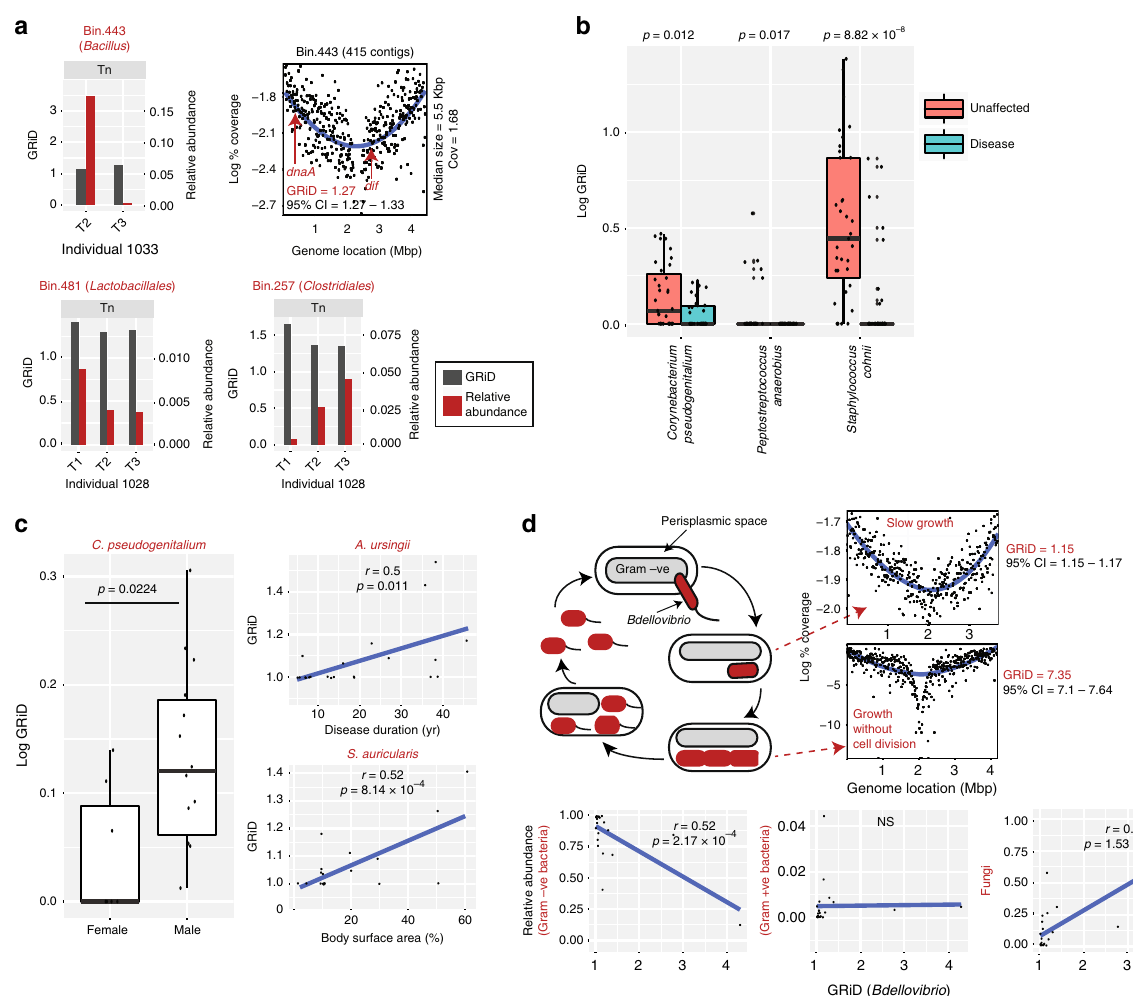
Fig. 2 GRiD uncovers new biology from human and environmental communities. a Growth rate of rare uncharacterized bacteria over time from a skin metagenomic dataset. Uncharacterized bacteria were identi fi ed using de novo assembly of reads and metagenomic binning, with each bin representing a genome. The sampling interval between timepoints T1 and T2 is 10 – 30 months while sampling intervals between T2 and T3 are 5 – 10 weeks. Tn = toenail. b Growth rate of bacteria that were signi fi cantly different ( p < 0.05, Wilcoxon rank-sum test) between unaffected and disease sites in a psoriasis skin metagenomic dataset. Center lines in boxplots represent the median and the edges represent the fi rst and third quartiles. c Inter-individual bacterial growth differences and association with patient characteristics. Each data point in the scatterplots represents the average GRiD score of each patient. Statistical differences between population groups were determined using the Wilcoxon rank-sum test while Spearman correlation was utilized for correlation coef fi cient analyses. d Growth dynamics of Bdellovibrio species. Flagellated Bdellovibrio penetrates the outer membrane of Gram-negative bacteria into the periplasmic space (losing its fl agella in the process), grows and elongates without cell division, resulting in a helical fi lament with multiple copies of the genome. As food supply from the host becomes exhausted, the fi lament divides by fi ssion into multiple smaller cells and exits the host. GRiD plots represent examples of different growth phases in the life cycle of Bdellovibrio obtained from marine and sludge environmental samples. The scatter plots below show Spearman correlation between Bdellovibrio growth and relative abundance of different group of microbes. Each data point represents the average GRiD score per sample. Source data are provided as a Source Data fi